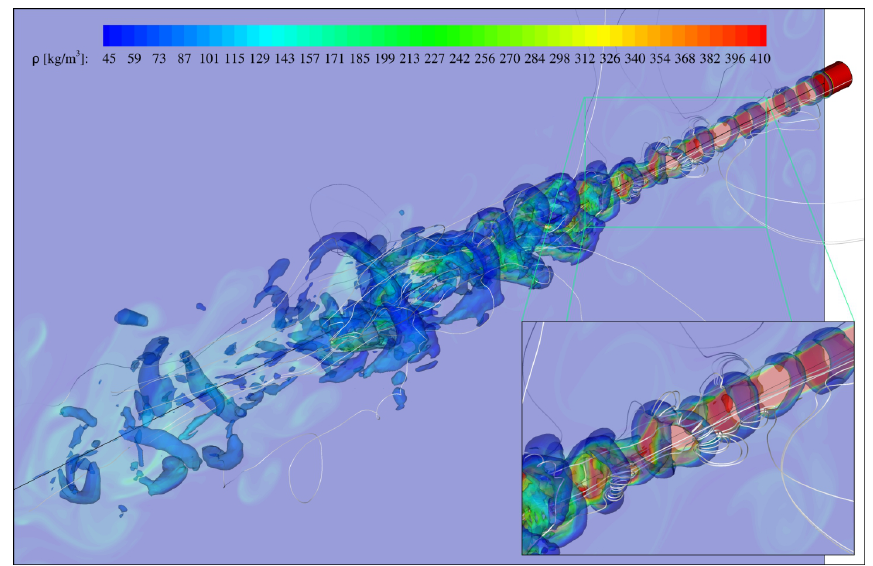
Figure 4. Instantaneous snapshot showing the spatial evolution of the coherent structures shed from the liquid N 2 injector in the Mayer test case. The vortex iso-surface identified by means of the Q-criterion are coloured by density levels.